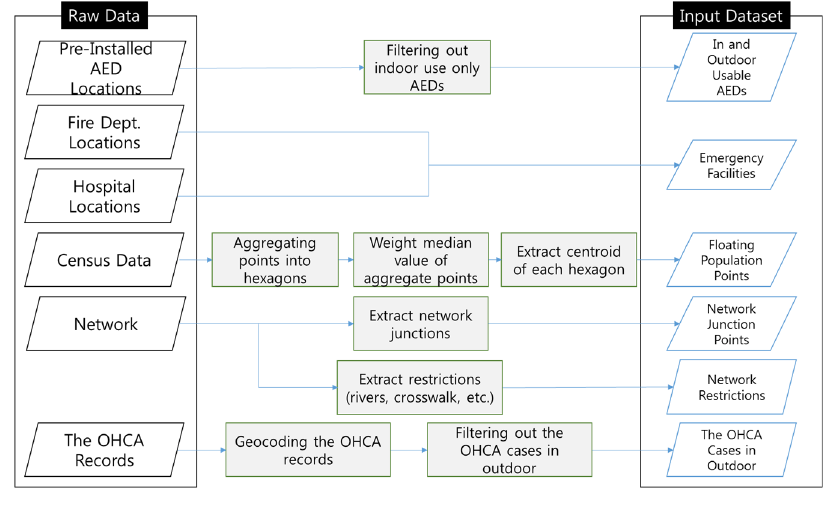
Figure 5. Data processing.